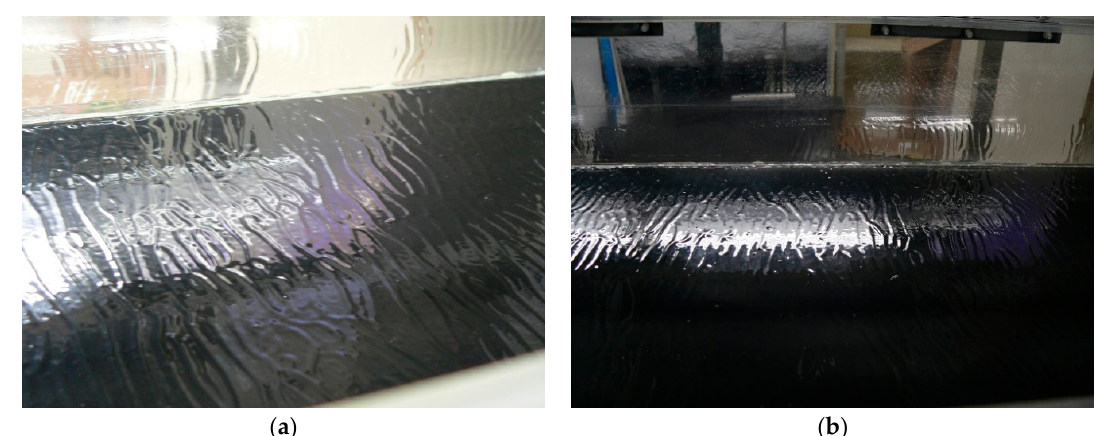
Figure 17. Fluid elimination for Ref. Fluid.